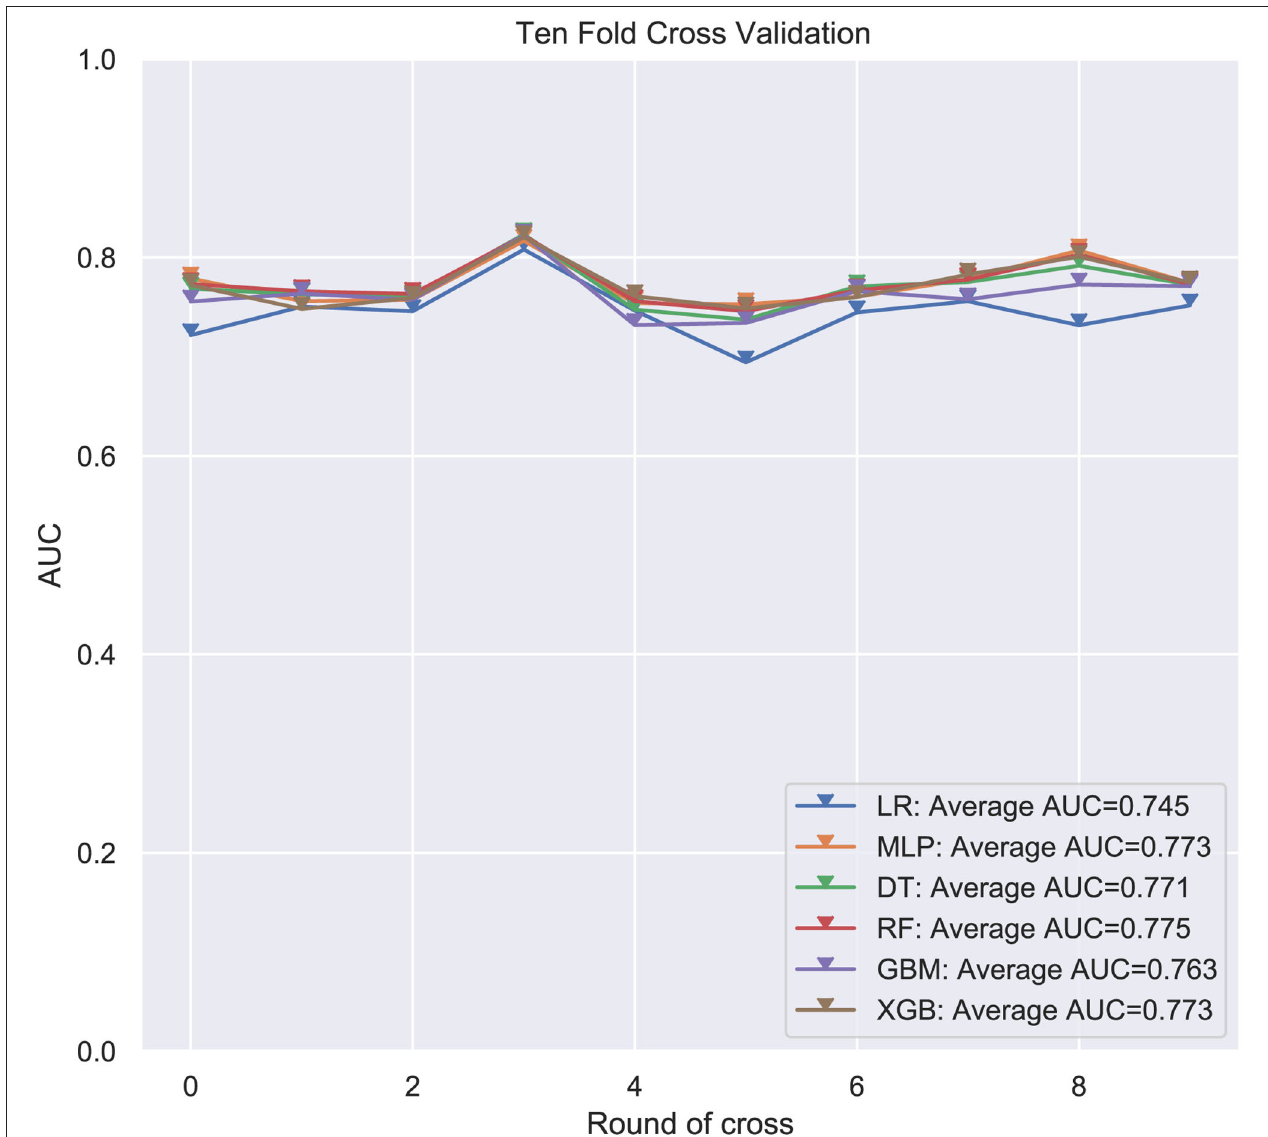
FIGURE 1 | Average area under the curve (AUC) values of 10-fold cross-validation. RF, Random forest predictive model; DT, Decision tree; XGB, Extreme gradient boosting; GBM, Gradient boosting machine; MLP, Multilayer perceptron; LR, Logistic regression; AUC used as an indicator of performance, RF model achieved the best predictive performance while the MLP model showed the